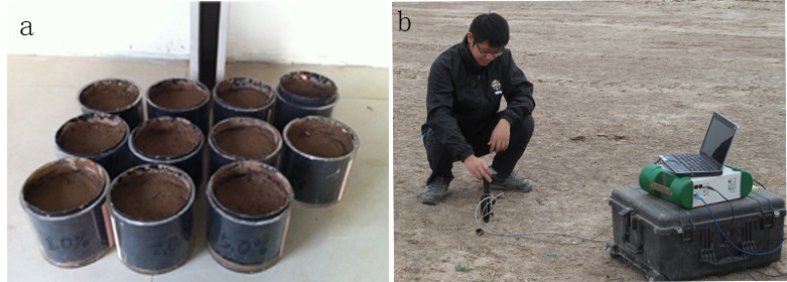
Figure 1. ( a ) Prepared soil samples for laboratory measurements and ( b ) in situ field experiment using the Analytical Spectral Device (ASD) AgriSpec (ASD, USA)